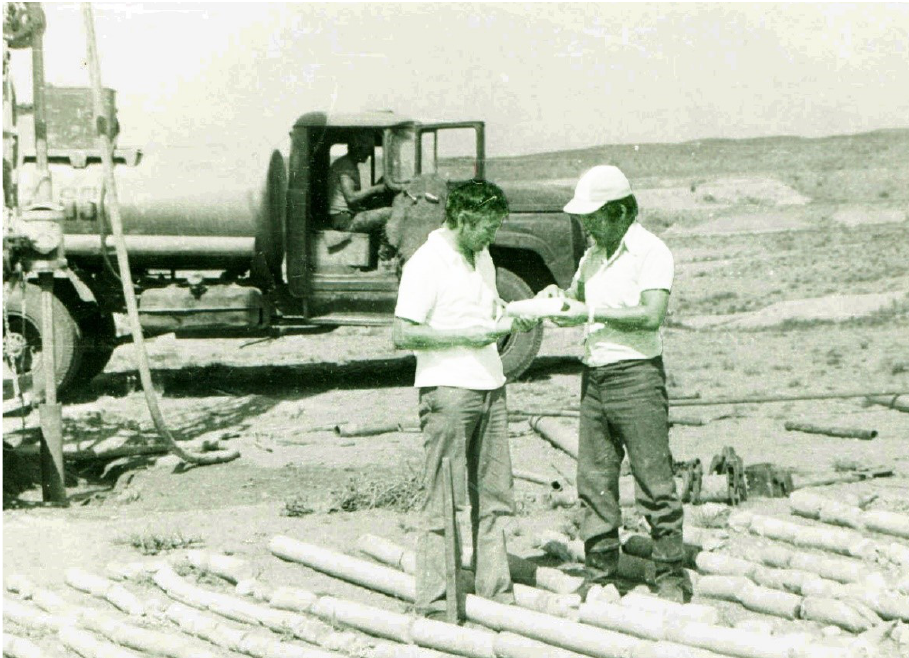
Fig. 6. First drilling of the Tsagaantsav zeolite deposit. Geologists D.Ivaanjav